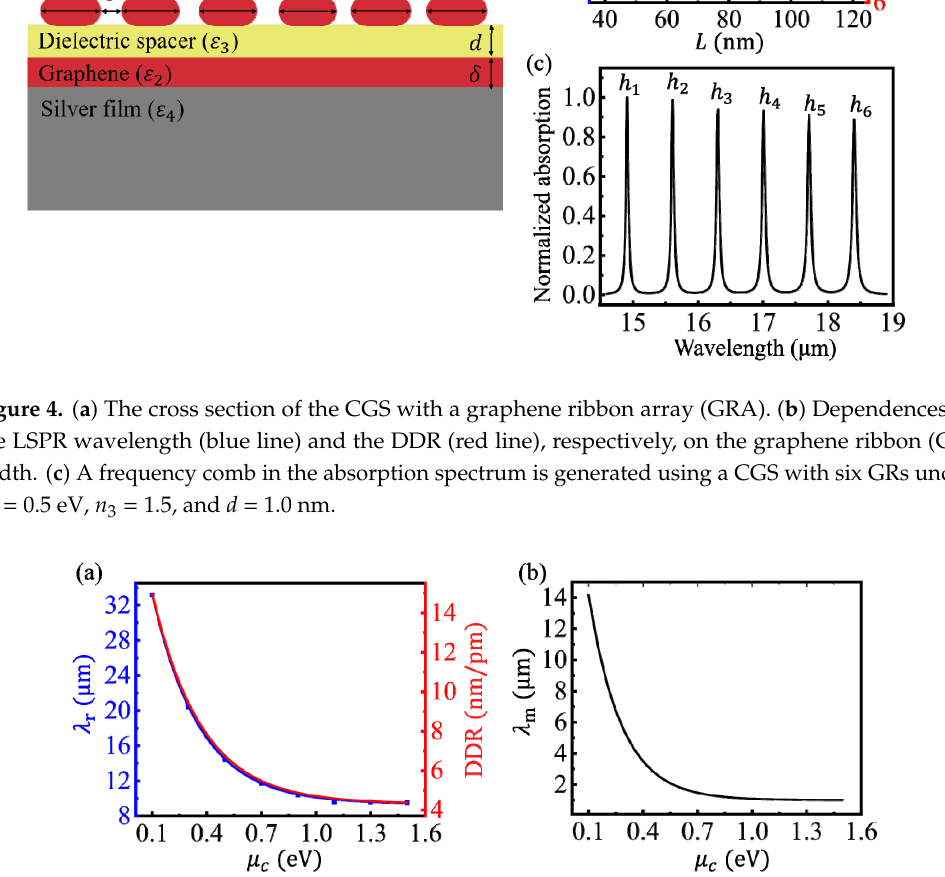
Figure 5. ( a ) Dependences of the LSPR wavelength (blue line) and the DDR (red line), respectively, on the chemical potential of the graphene under L = 40 nm, n 3 = 1.5, and d = 1.0 nm. ( b ) The dependence of λ m on μ c .